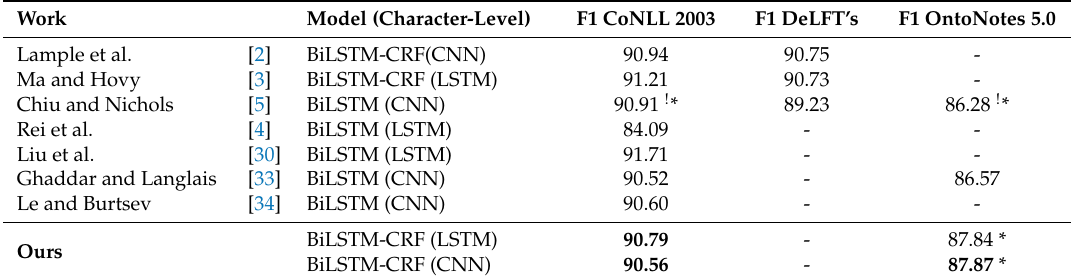
Figure 7. The comparison between the character-level CNN-based and LSTM-based word encodings in our delayed combination model. The result shows that the LSTM approach is better on the CoNLL2003 while the CNN approach is very slightly better on the OntoNotes5.0. Table 5. Comparison between our work and previous early combination model with the pre-trained word embedding and the character-level word encoding.